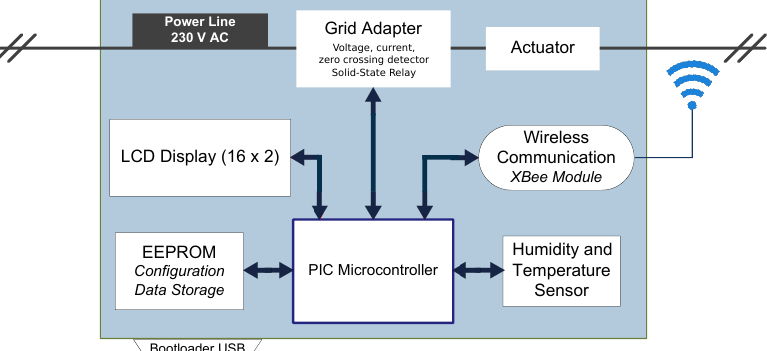
Figure 3. Sensor node: general scheme.